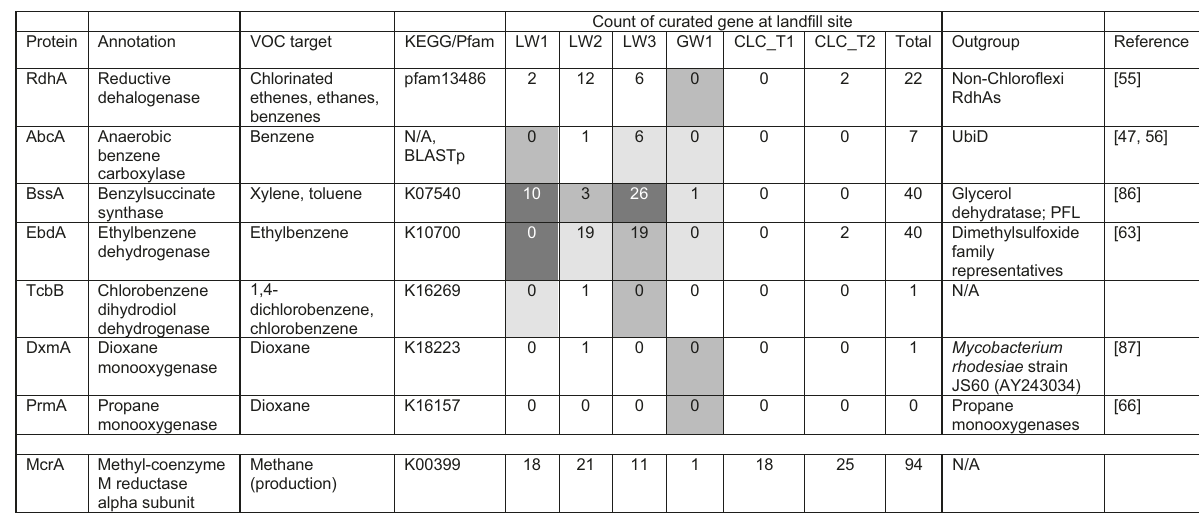
Cells for LW1,2, and 3 and GW1 are shaded based on concentration of the relevant VOC at that site, with absence in white and gradation of grey (light = 1 – 10 µg/L, medium = 10 – 50µg/L, dark = >50 µg/L). Geochemical information was not available for the CLC site. Dioxane degradation proteins